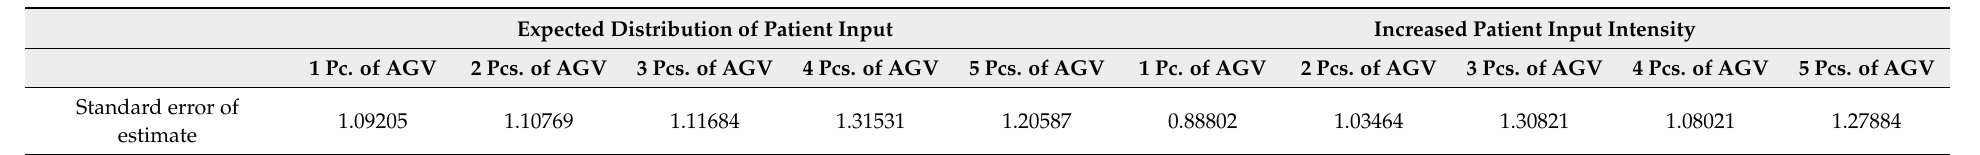
Table 5. Estimation error of simulation experiments carried out for disinfection if no patients are in the